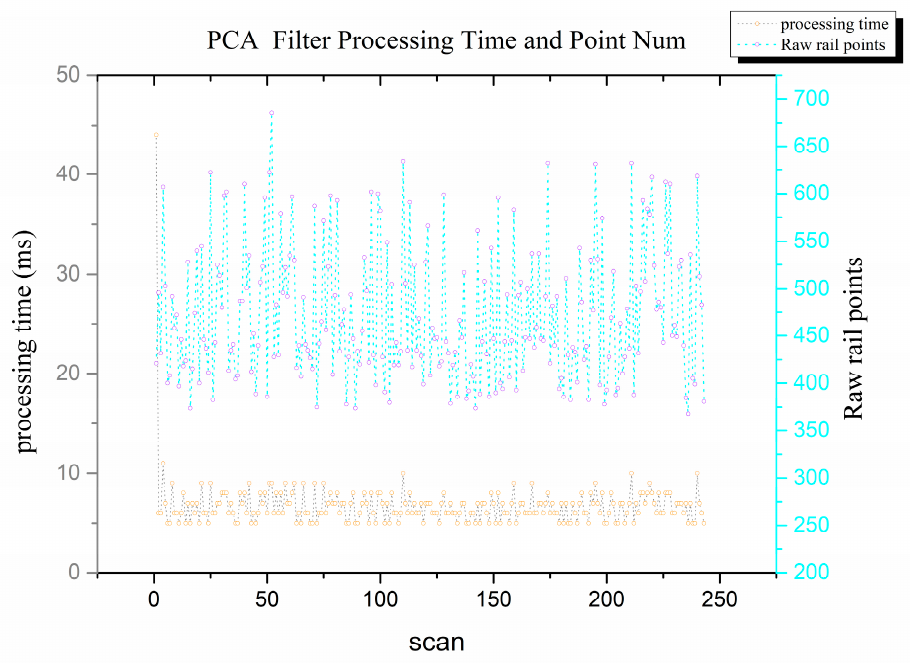
Figure 13. Timing of raw rail extraction step and point number of every scan.